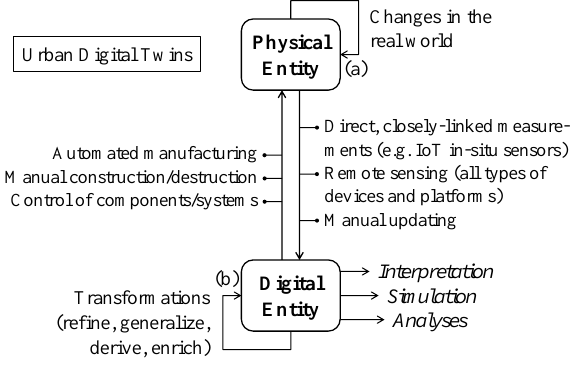
Figure 1. An overview of urban digital